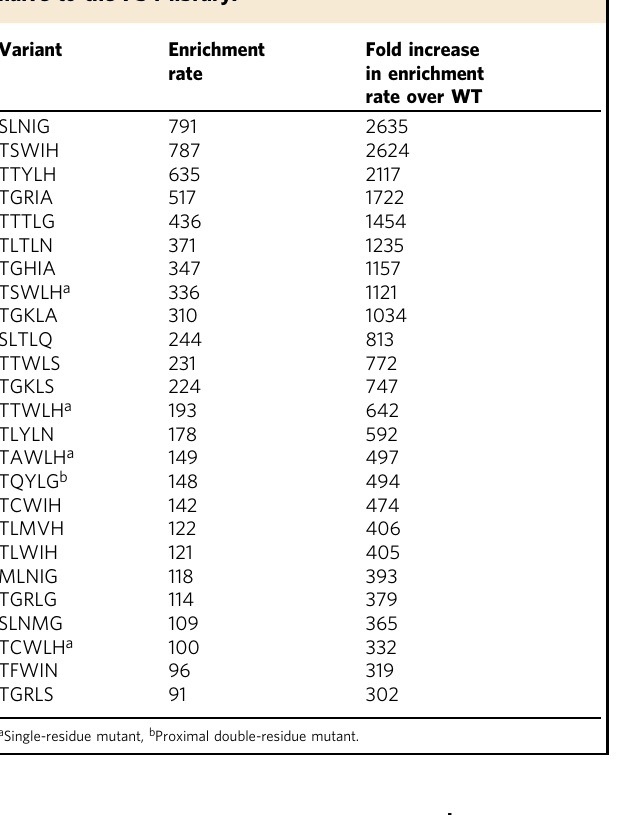
Table 1 Top 25 variants ranked by enrichment rate from the naive to the PS4 library.